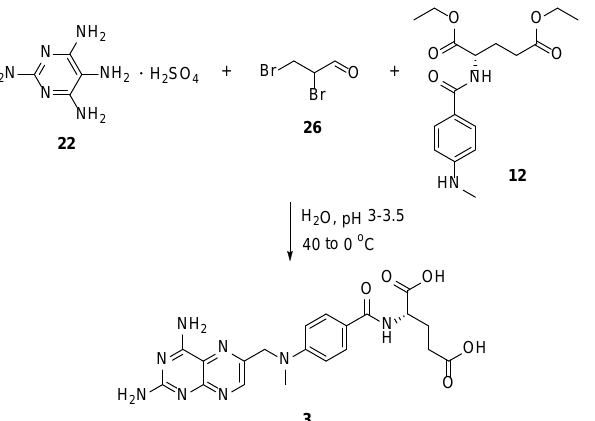
Scheme 13. Synthesis of MTX by the reaction between 2,4,5,6-tetraaminopyrimidine hydrosulphate 22 , 2,3-dibromopropionaldehyde 26 , and N -4-(methylamino)benzoyl)- L -glutamic acid 12 disodium salt under oxidative conditions.